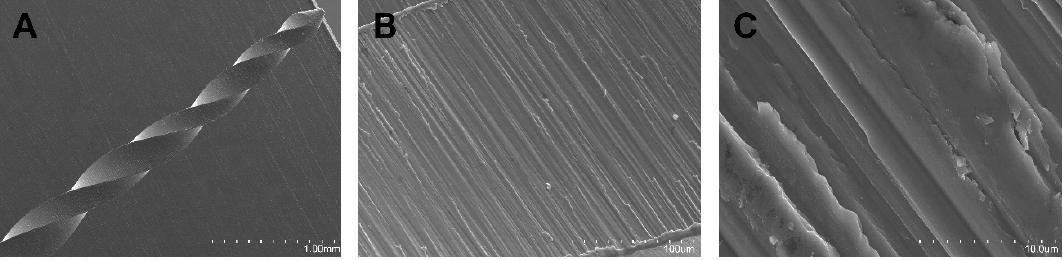
Figure 9. SEM images of M-Wire alloy ProTaper Next (PTN) endodontic rotary files at ( A ) 100 × , ( B ) 3600 × , and ( C ) 6500 × .